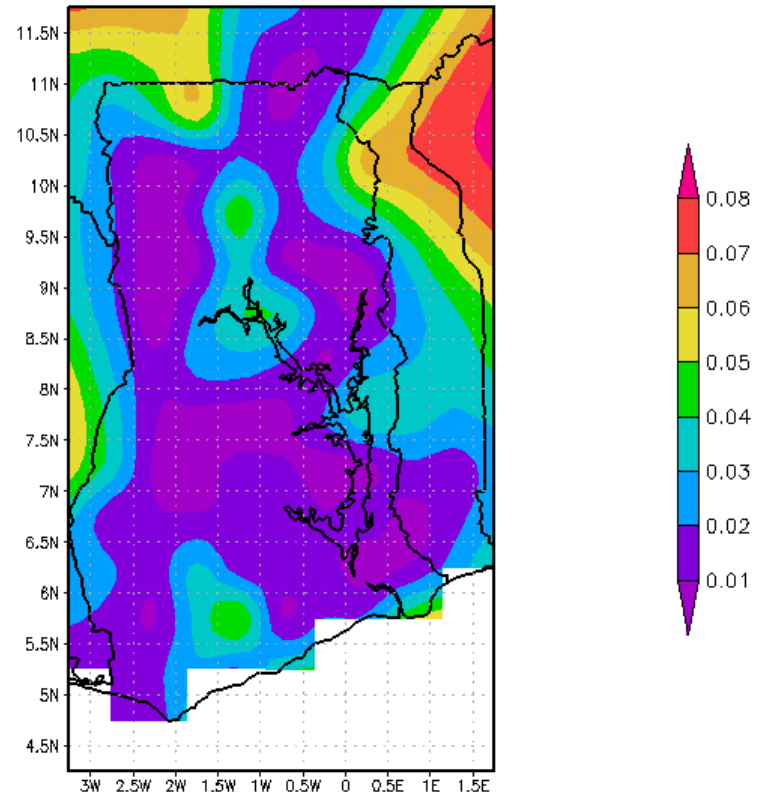
Figure 5. Relative Mean Difference between GPCC and GMet data from